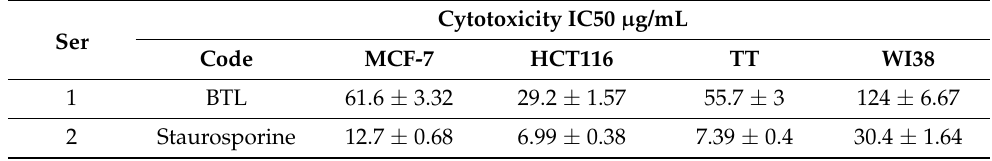
Table 1. Inhibition concentration (IC50) of Clitoria ternatea versus HCT116, MCF-7, and TT cell lines.